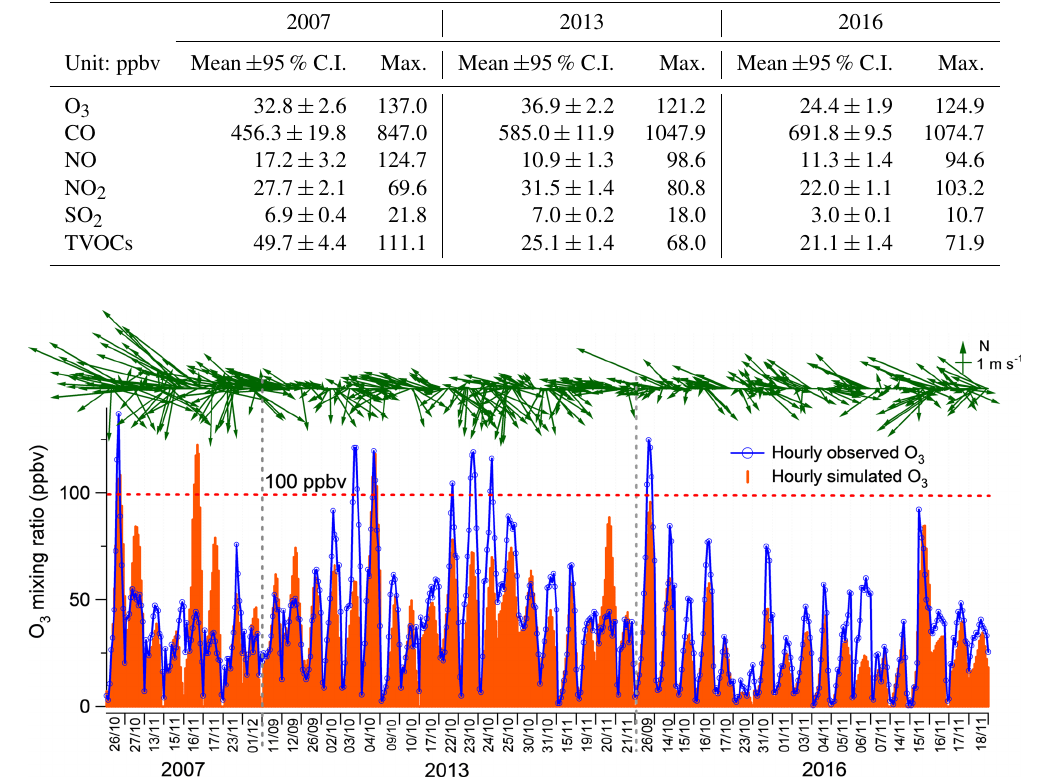
Figure 3. Hourly mixing ratio of the simulated and observed O 3 at TC during the VOC sampling periods in 2007, 2013 and 2016. The arrows represent the hourly wind sectors monitored at the sampling